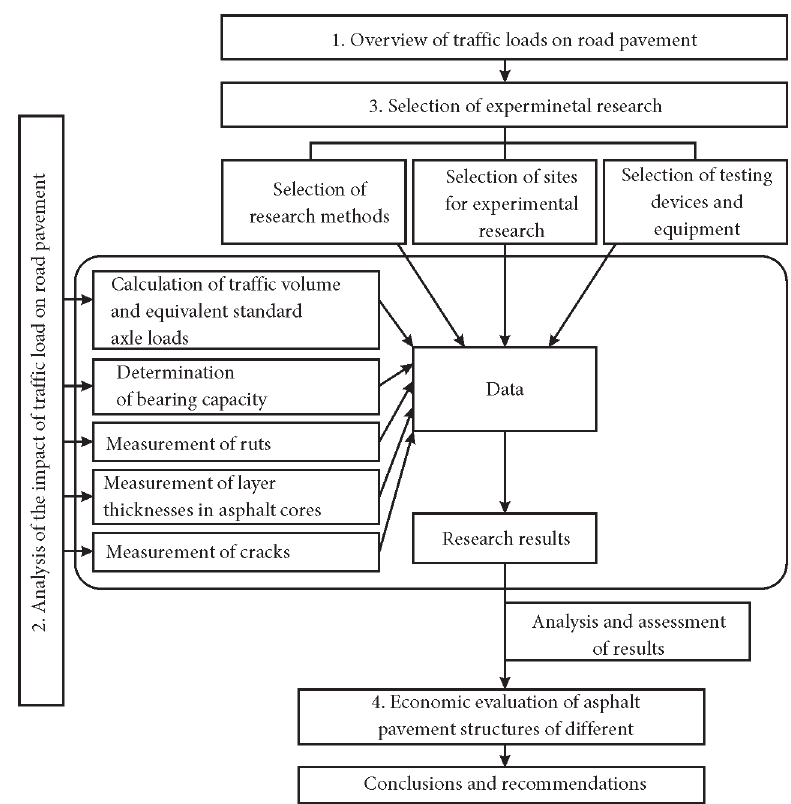
fig. 1. The process of experimental Table 1. Materials used to construct asphalt pavement layers No. of pavement structure